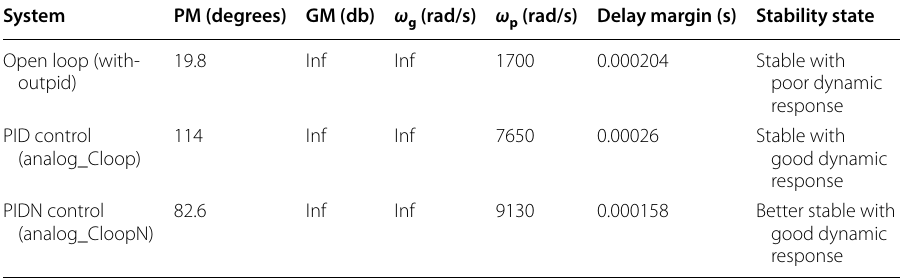
Table 3 Comparison of stability analysis in analog domain of BBC in boost mode of operation